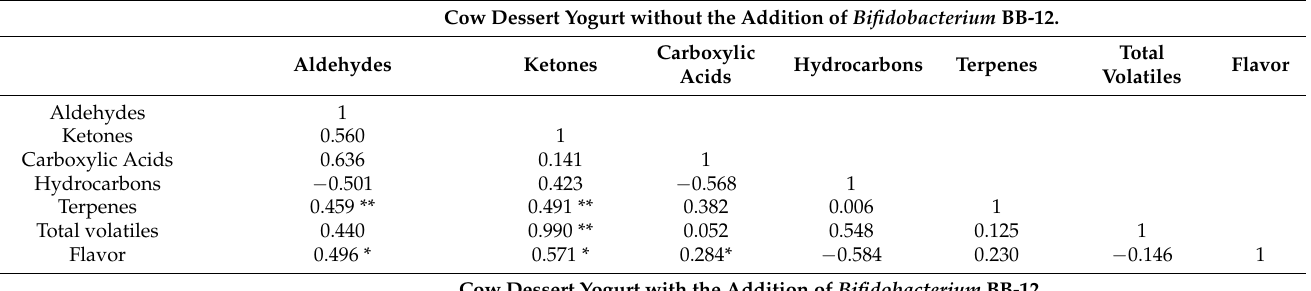
Table 6. Correlation of dessert yogurt volatile compounds to organoleptic evaluation results. Cow Dessert Yogurt without the Addition of Bifidobacterium BB-12. Carboxylic Aldehydes Ketones Hydrocarbons Terpenes Acids